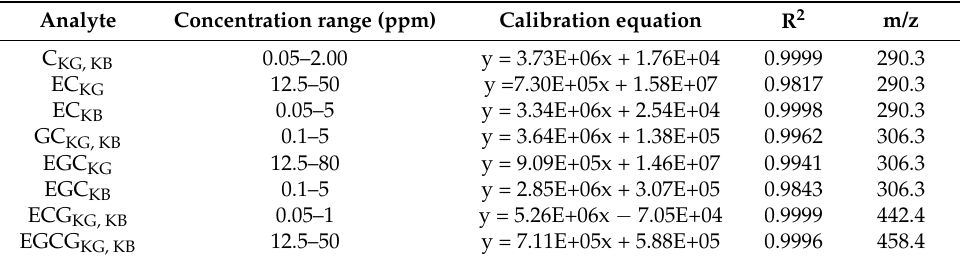
Table 6. Calibration curves with correlation coefficient (R 2 ) and m/z value for each catechins. Analyte Concentration range